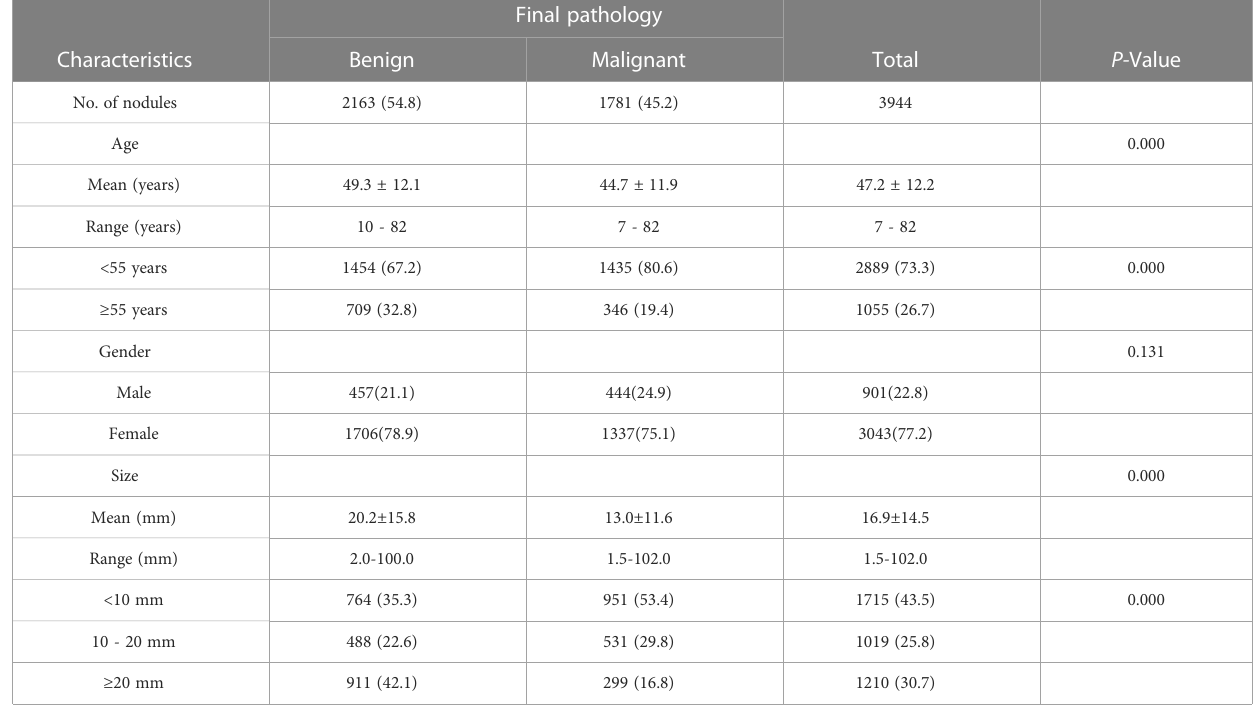
TABLE 2 Summary of demographic features for the patients with thyroid nodules.